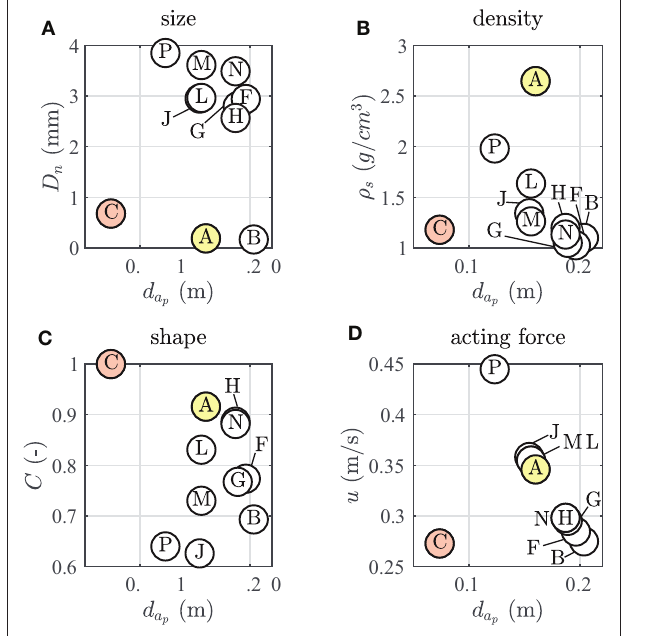
FIGURE 10 | Particle properties [ (A) size, (B) density, (C) shape, and (D) acting force] over water depth d at corresponding accumulation peak a p .